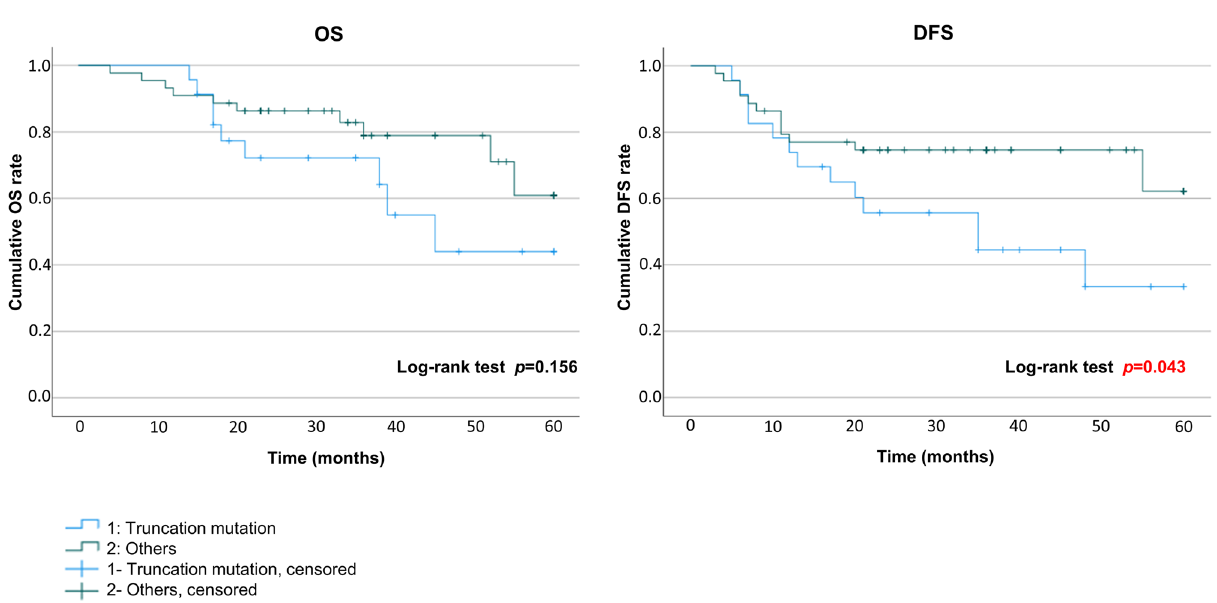
Figure 5. Overall survival (OS) and disease-free survival (DFS) in patients with oral squamous cell carcinoma (OSCC) with p53 truncation and non-truncation mutations. There was no significant difference in OS ( p = 0.156) between the groups, but DFS was significantly poorer in patients with truncation mutations ( p =